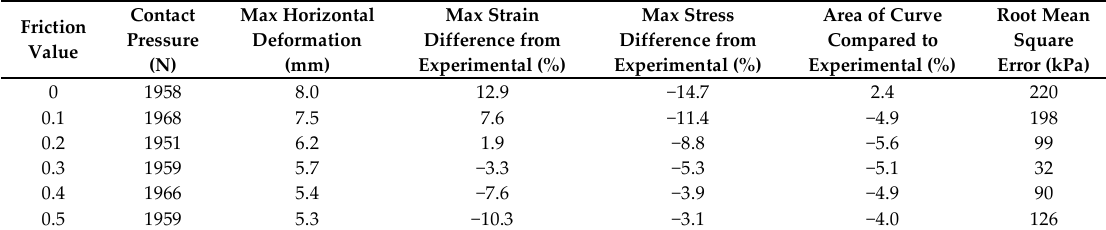
Figure 5. Nominal stress strain curves produced using different coefficients of friction for test condition B compared to experimental test curve. Table 2 . Key values taken from FE model for test condition B compared to experimental test data. Comparison values are given as a percentage of the